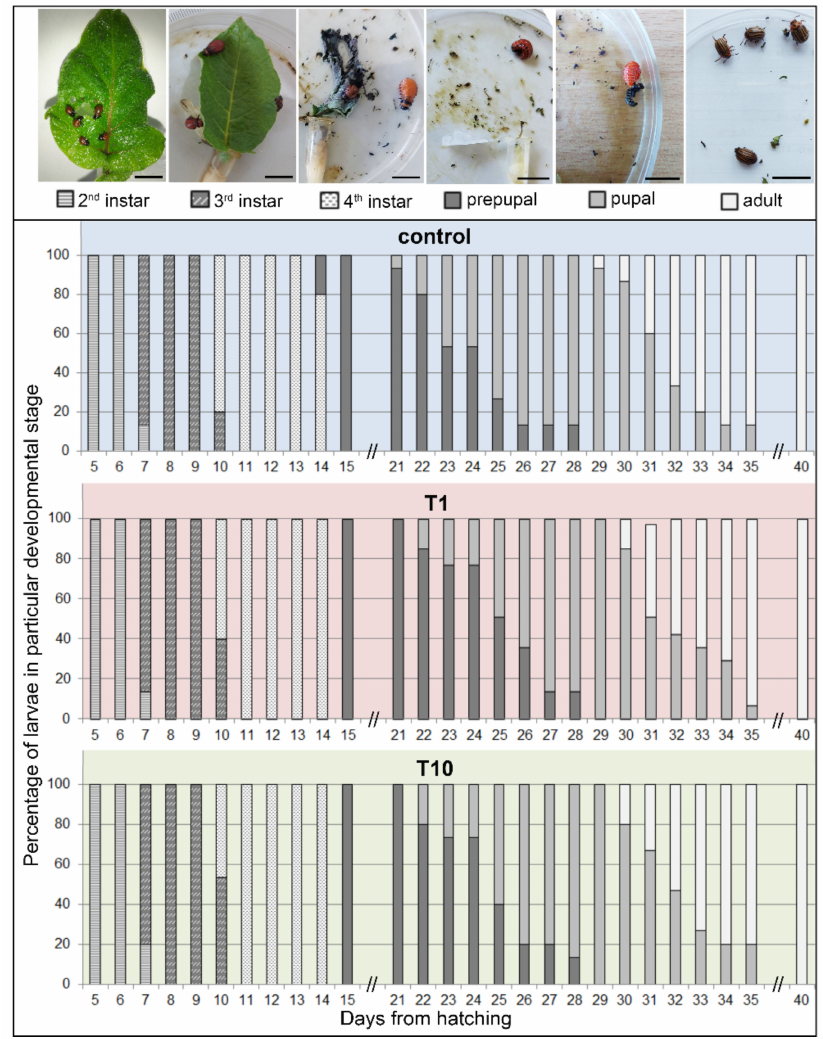
Figure 4. Effect of French marigold methanol extract of flowers on CPB larval development. The potato leaves coated with extract in concentrations of 1 mg/mL (T1) and 10 mg/mL (T10), were used as food for CPB larvae during development from 2nd, through 3rd, and 4th instars. The overall developmental pattern was compared with larvae fed on control leaves. Results are presented as a percentage of larvae in the particular developmental stage for each day during the entire development. Bars represent 1